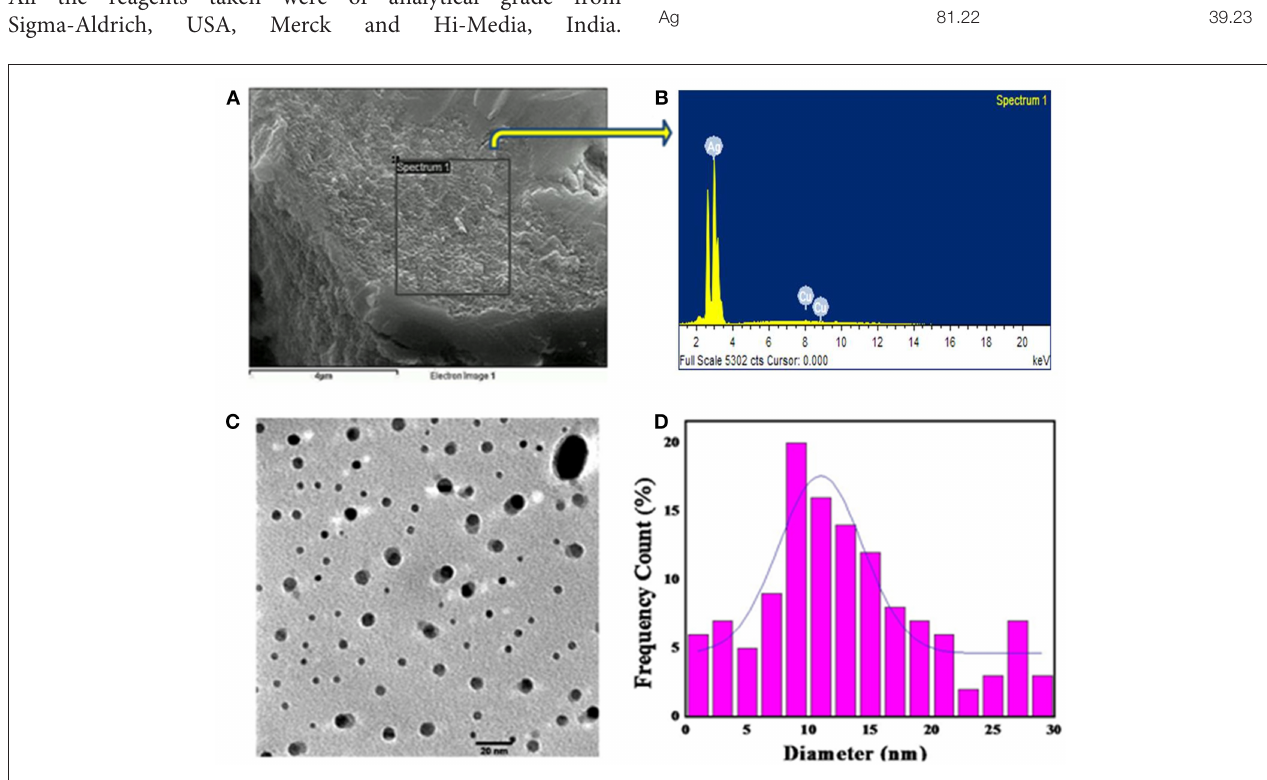
FIGURE 2 | Morphological characterization of P. indica- derived Ag NP. (A) SEM image of biogenic Ag NPs (scale bar indicates 4 µ m); (B) EDX spectrum of biogenic Ag NPs; (C) TEM image of the biogenic Ag NPs (scale bar indicates 20nm); (D) Histogram of the size distribution of biogenic Ag NPs.